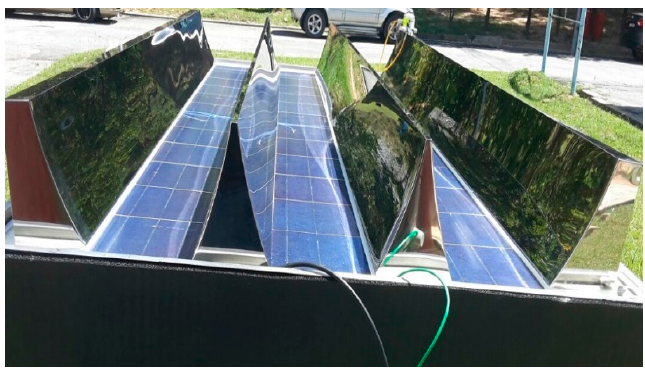
Figure 1. Photograph of the photovoltaic compound parabolic concentrator (PVT-CPC) collector. Table 1. Specification sheet of the photovoltaic (PV) module.